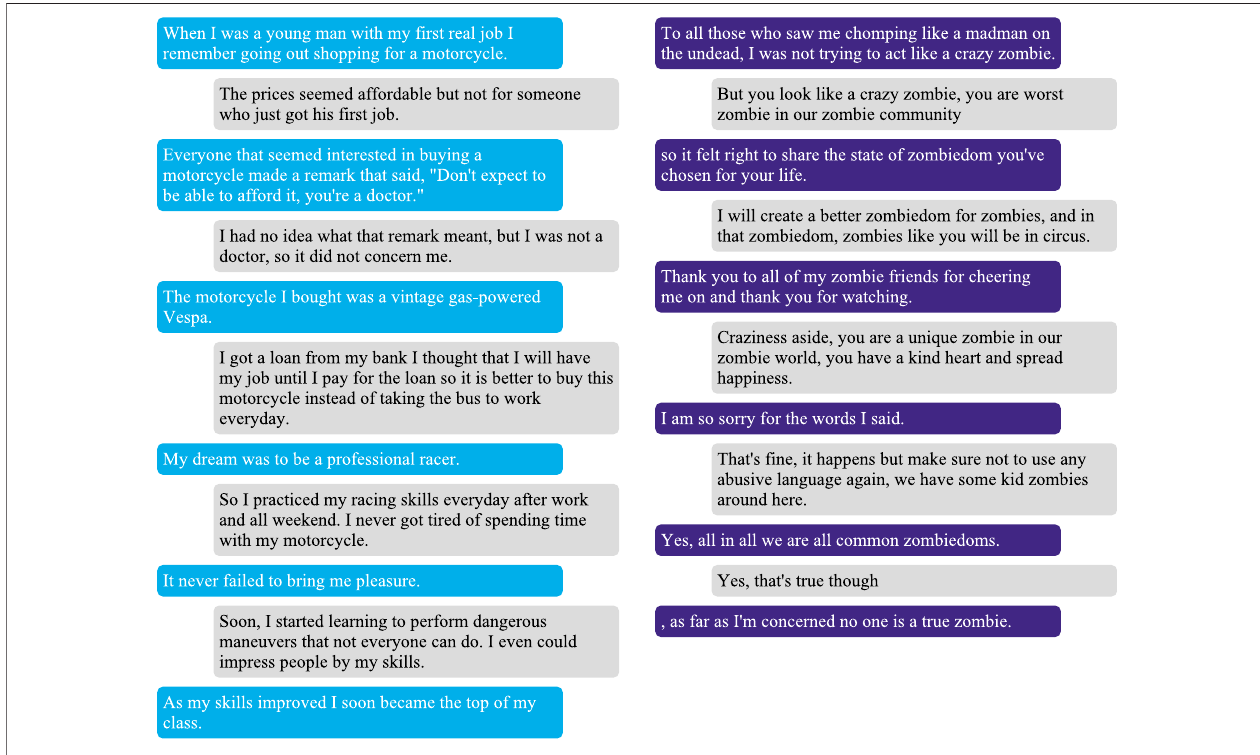
FIGURE 7 | Examples stories by univ. students and collaborative storytelling systems: ranker30 (left) and untuned (right) .